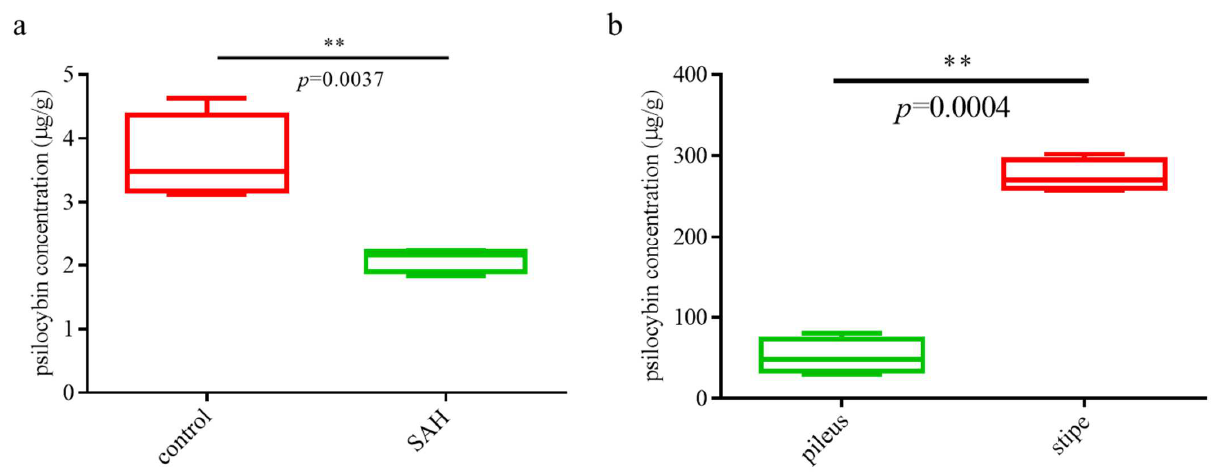
Figure 1. Quantitative analysis of psilocybin using UPLC (( a ): Boxplots of psilocybin levels in samples after SAH treatment; ( b ): Boxplots of psilocybin levels in pileus and stipe; Paired t -test, ** indicated p < 0.01).